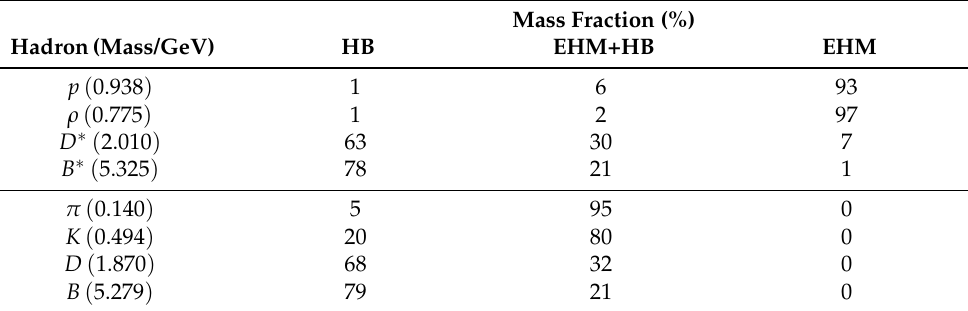
Table 1. Mass budgets of a collection of hadrons, with each panel ordered according to the contribution from Higgs boson couplings into QCD (HB) and including the component that is entirely unrelated to the Higgs (EHM) and that arising from constructive interference between these two mass sources (EHM+HB) (separation at ζ = 2 GeV , produced using information from